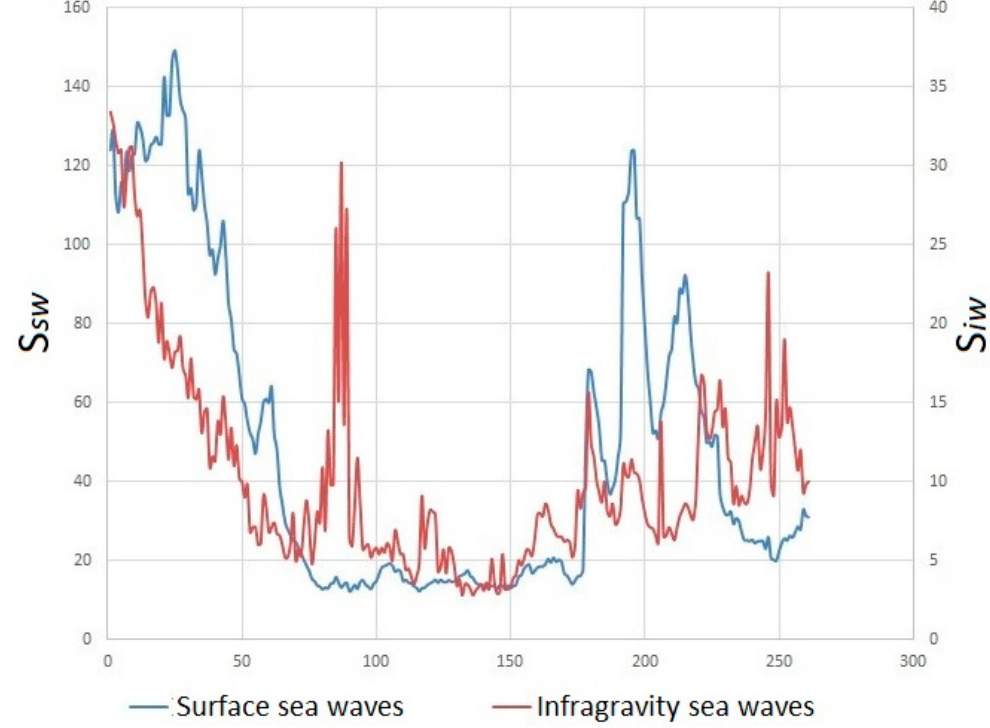
Figure 13. Change in the relative energy of surface sea waves ( S sw ) and infragravity sea waves ( S iw ). Some abrupt increase in the relative energy of infragravity sea waves in comparison with the relative energy of surface sea waves (abrupt surges in files 87–91) was associated with the presence of solitary waves in the records of the laser meter of hydrosphere pressure variations, which, upon spectral processing, significantly increased the relative energy in the infragravity range and did not increase the relative energy in the sea wave range. 5. Conclusions After the studies in the range of gravity sea waves, the following conclusions could be drawn: (1) When comparing the polynomial regression and the general function of the period change, with the help the analysis we conducted of the change in the swell waves periods during the passage of the typhoon through the Sea of Japan, we determined that the difference in the quality of describing this process was insignificant. Thus, to describe wave processes of this type, the general period change function could be used instead of high-order polynomial regressions. (2) The assumption about the generation of waves of a certain period when the typhoon moved at a certain speed at an angle to the receiver looked convincing, if we assume that these periods are formed by the leading front of the typhoon, while the wind condition in the typhoon, which can affect the amplitude of these wave periods, plays an important role. This effect could also explain the variety of periods of swell waves, created by the typhoon. (3) Separate peaks of certain periods in the typhoon spectrum and simultaneous arrival to the registration point could be explained by the group propagation of swell waves, when waves with the largest period captured the waves with a period close to their own, and the entire group propagated at a speed of the largest period, which was two times less than the phase speed. (4) Using the formula for the group speed of wave propagation in deep water conditions, knowing the duration of the interval of period change from maximum to minimum, we could quite accurately determine the distance to the source, from which these waves came. The linear effect of